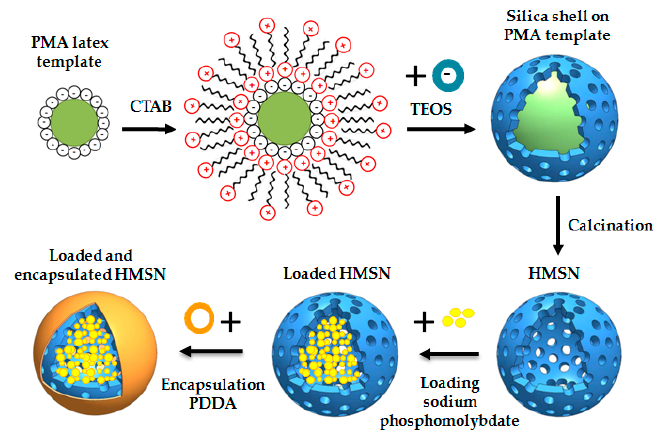
Figure 1. Synthesis of HMSN, loading with sodium phosphomolybdate and deposition of an external PDDA layer.